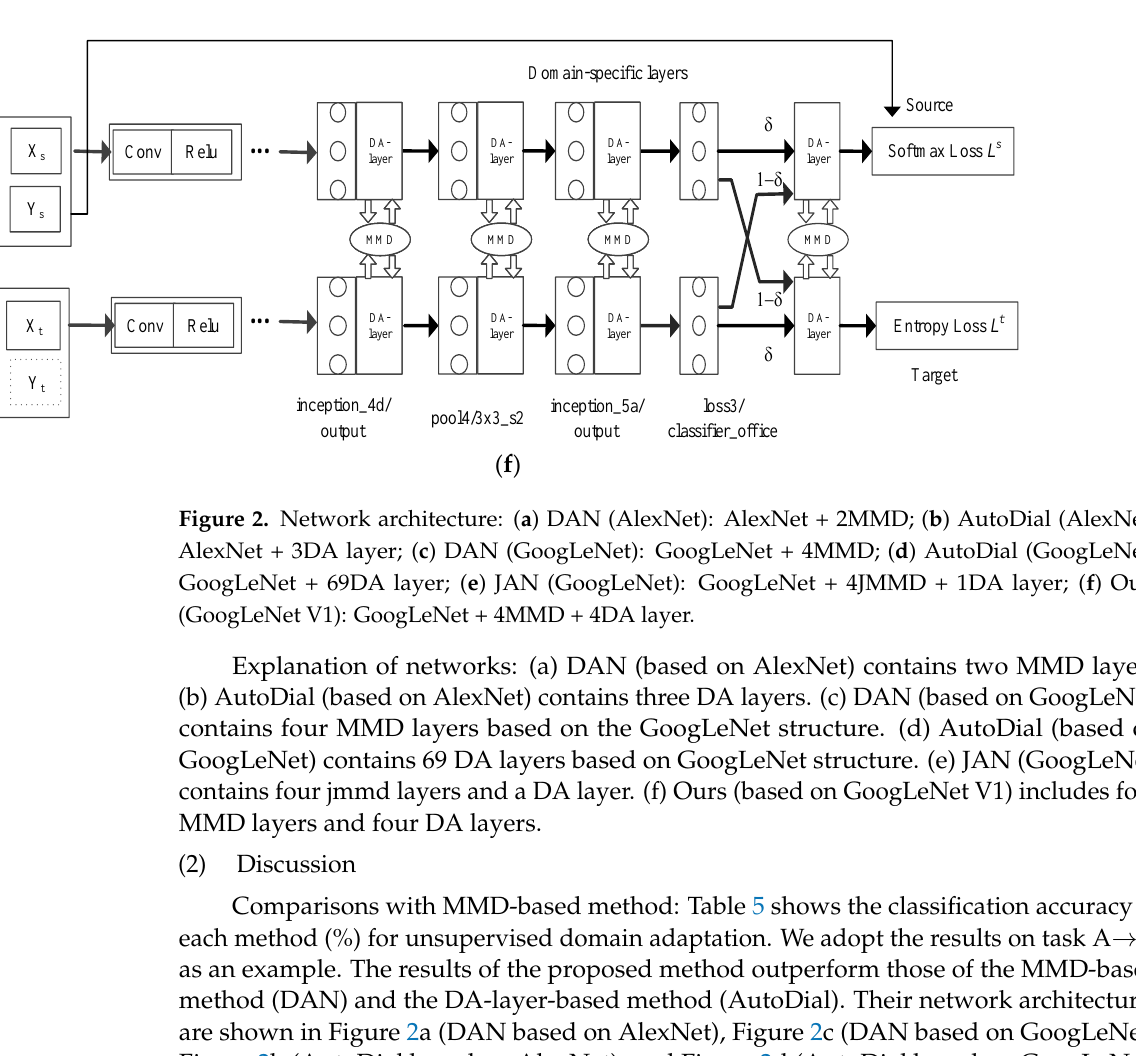
Table 5. Ablation study: a description of the network architecture and the classification accuracy achieved by each method (%) for unsupervised domain adaptation (the results on task A → W were used as an example).